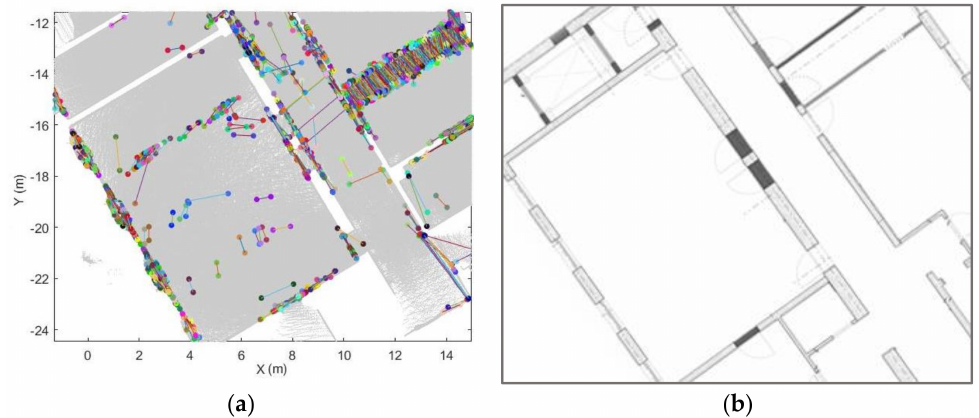
Figure 9. Example of extracted opening candidates in xy-plane ( a ) and it corresponding floor plan ( b ) (each opening candidate shown in a different colour).